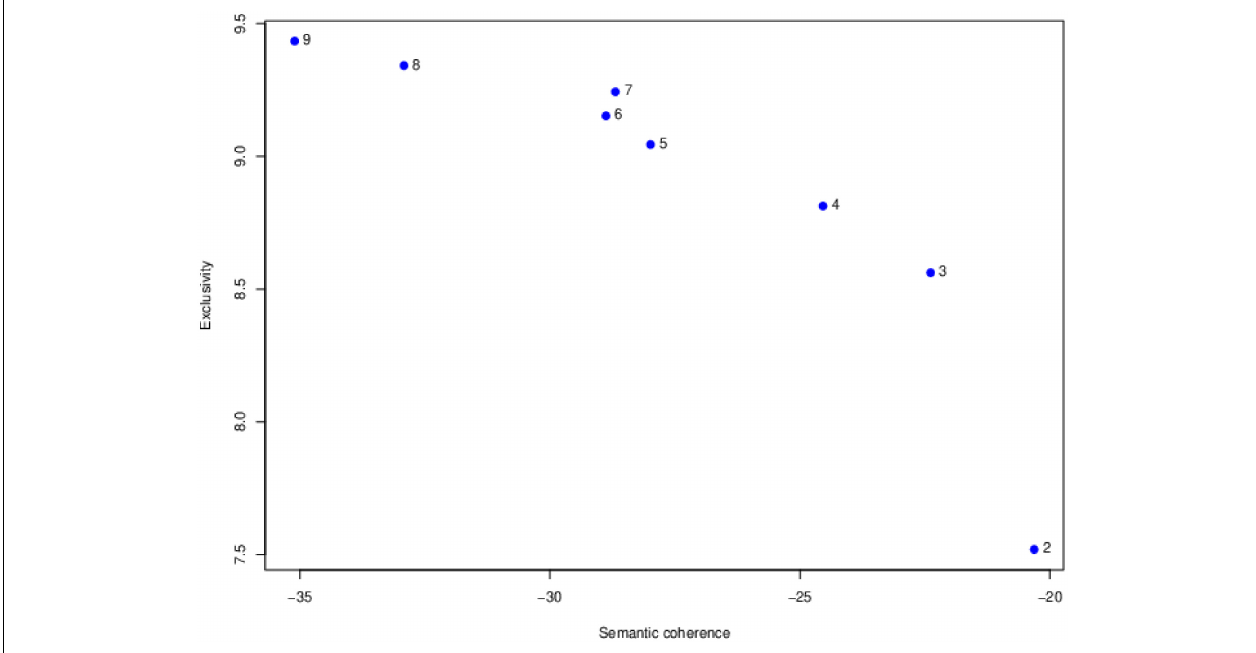
FIGURE 2 | Comparisons semantic coherence and exclusivity among 2- to 9-topic structural topic